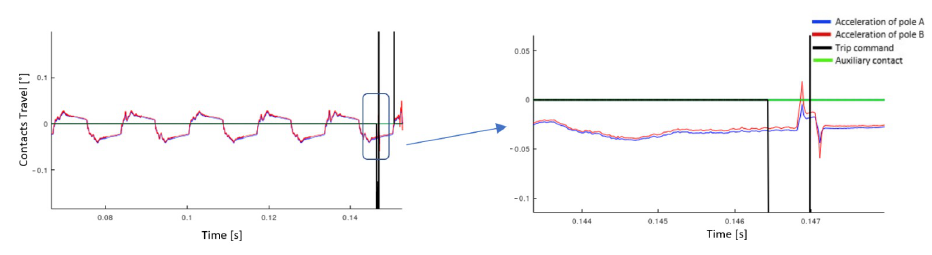
Figure 7. Instantaneous closing command (part